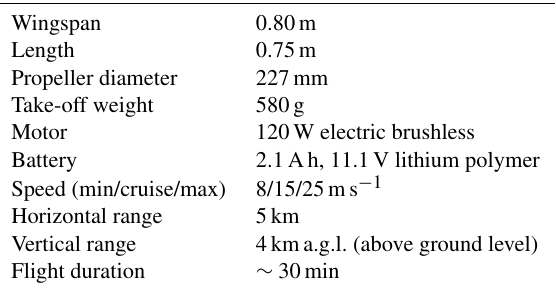
Table 1. SUMO sUAS airframe and flight specifications (based on Reuder et al., 2012; Cassano,